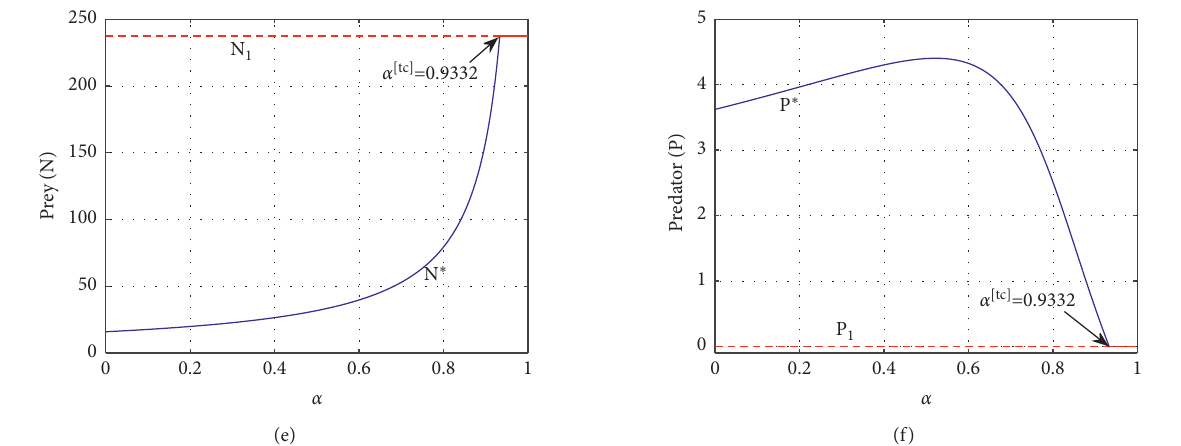
� ( N ,P ) � (( r − d ) / a, 0 ) and E � ( N ∗ , P ∗ ) , 1 1 1 2